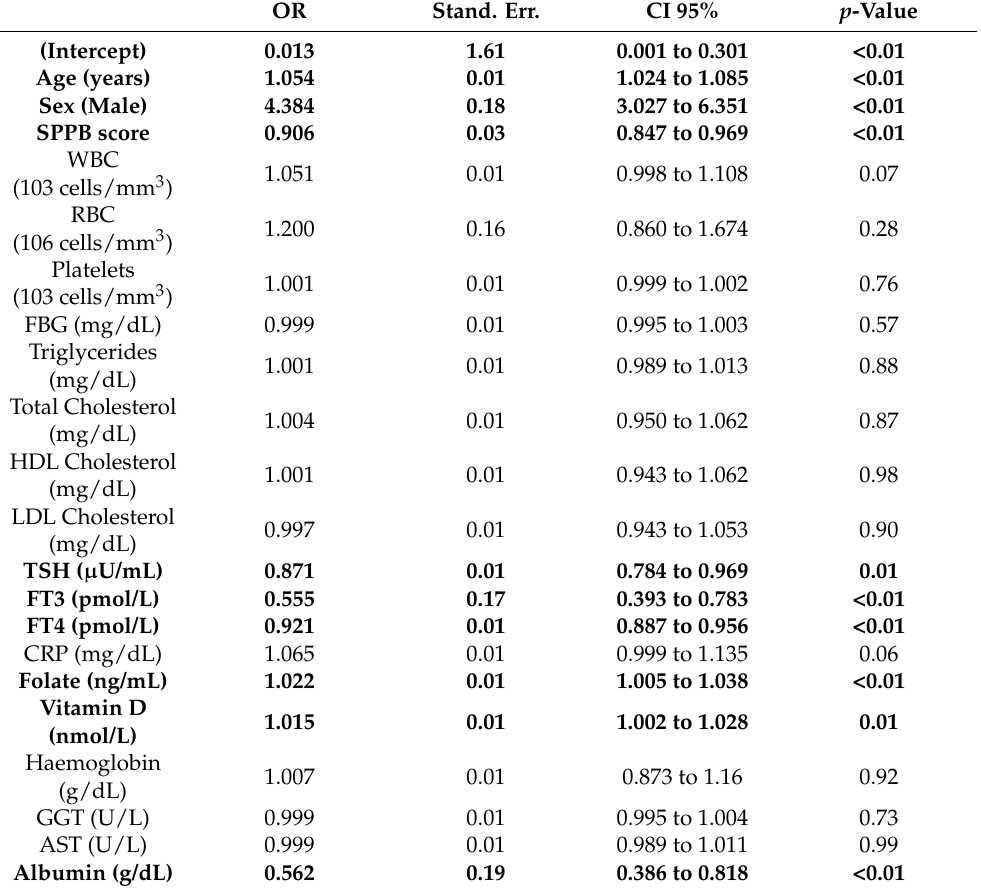
Table 4. Logistic regression model with sarcopenic condition as the dependent variable and all haematochemical features as regressors. OR Stand.